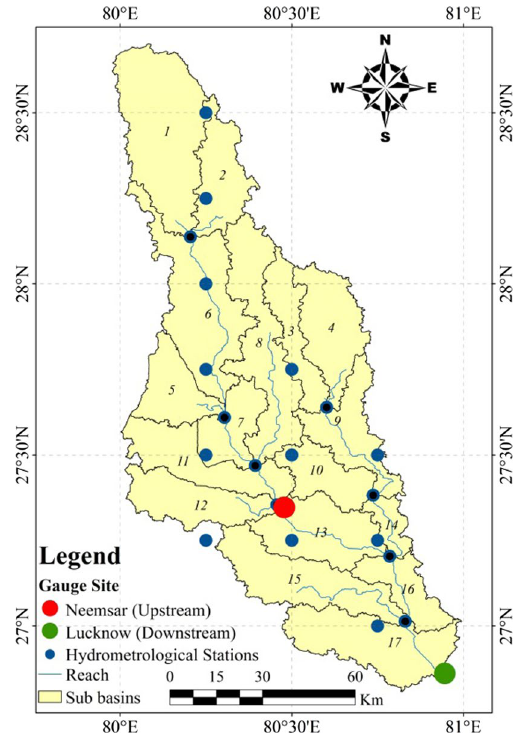
Fig. 3 LULC map of the study area